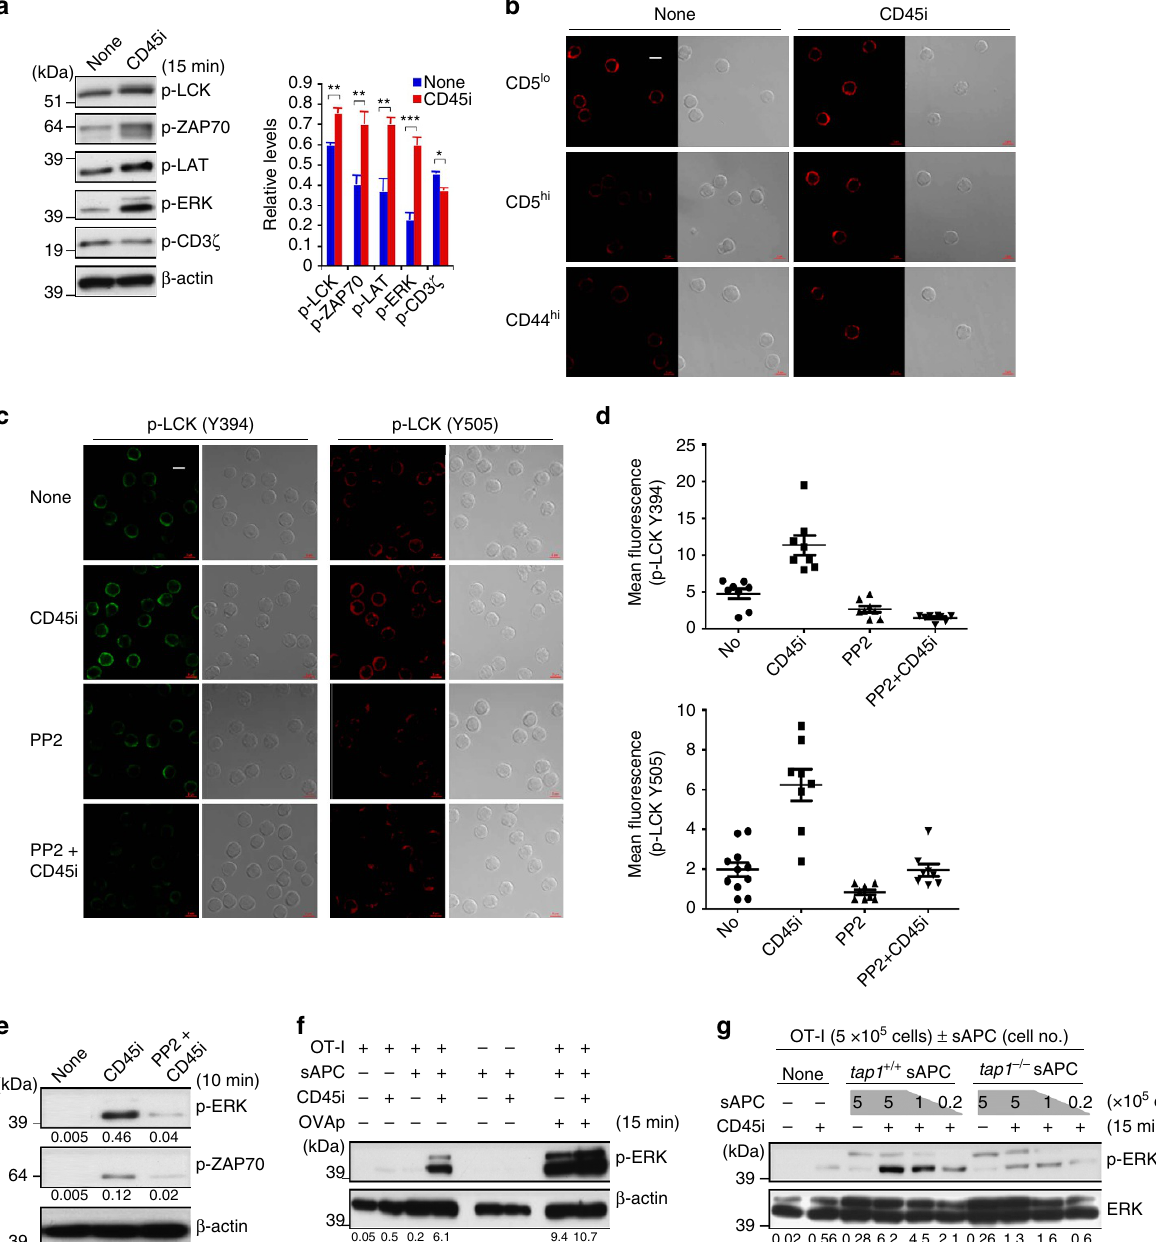
Figure 7 | Influence of CD45 blockade on basal TCR signalling. ( a ) Levels of phosphorylated LCK, ZAP-70, LAT, ERK, and CD3 z in purified unstimulated CD44 lo B6 CD8 þ Tcells with or without brief culture with CD45i (5 m M; means ± s.d.). ( b ) Confocal staining for p-Y394-LCK in freshly isolated CD44 lo naı¨ve CD5 lo and CD5 hi cells and CD44 hi MP CD8 þ T cells at 15min after incubation with or without CD45i (5 m M; original magnification (cid:3) 63; (cid:3) 1.4 zoom; scale bars, 5 m m). ( c ) Confocal staining for p-Y394-LCK and p-Y505-LCK in freshly isolated naı¨ve CD8 þ Tcells at 15min after incubation with or without PP2 (2 m M), CD45i (5 m M) or both (original magnification (cid:3) 63; (cid:3) 1.4 zoom; scale bars, 5 m m). ( d ) MFI levels for p-LCK per each cell visualised by confocal staining as in ( c ) (means ± s.d.). ( e ) ERK and ZAP-70 phosphorylation in unstimulated B6 naı¨ve CD8 þ T cells with or without